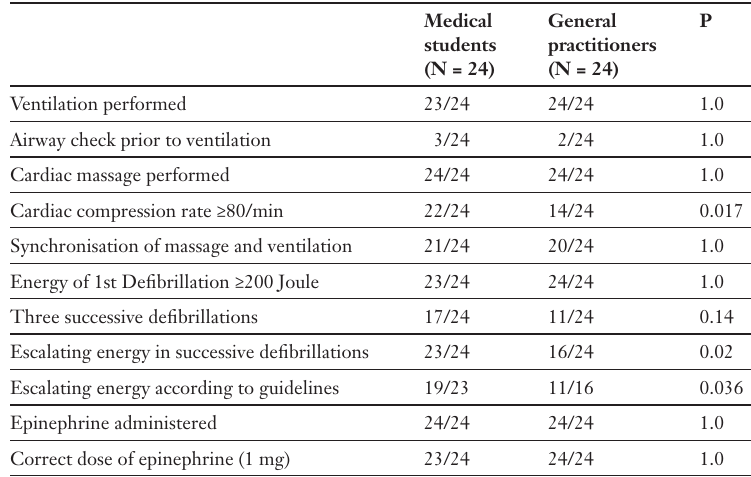
Ratings of the technical perfor- mance during cardiopulmonary resuscitation in simulated cardiac